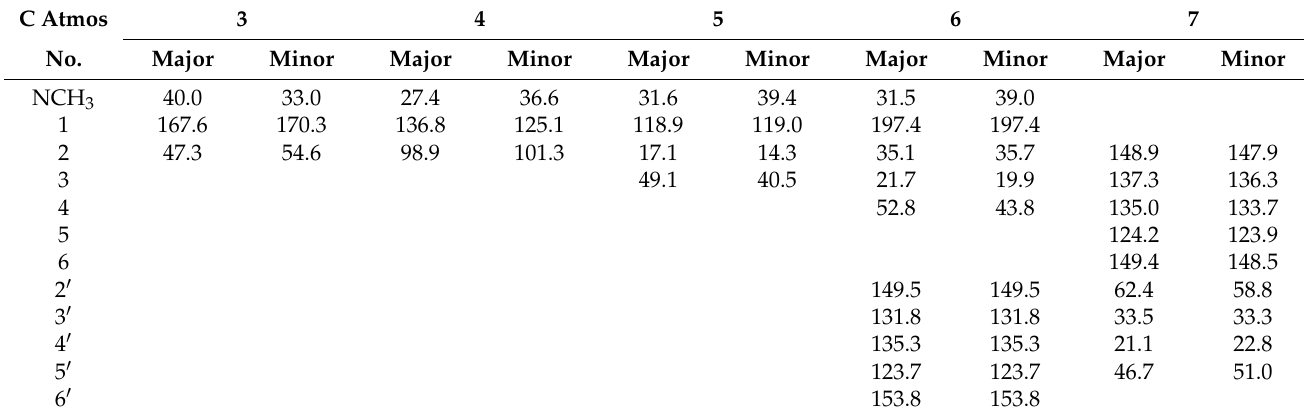
Table 2. 13 C-NMR chemical shifts of asymmetrical N-nitrososarcosine 3 – 7